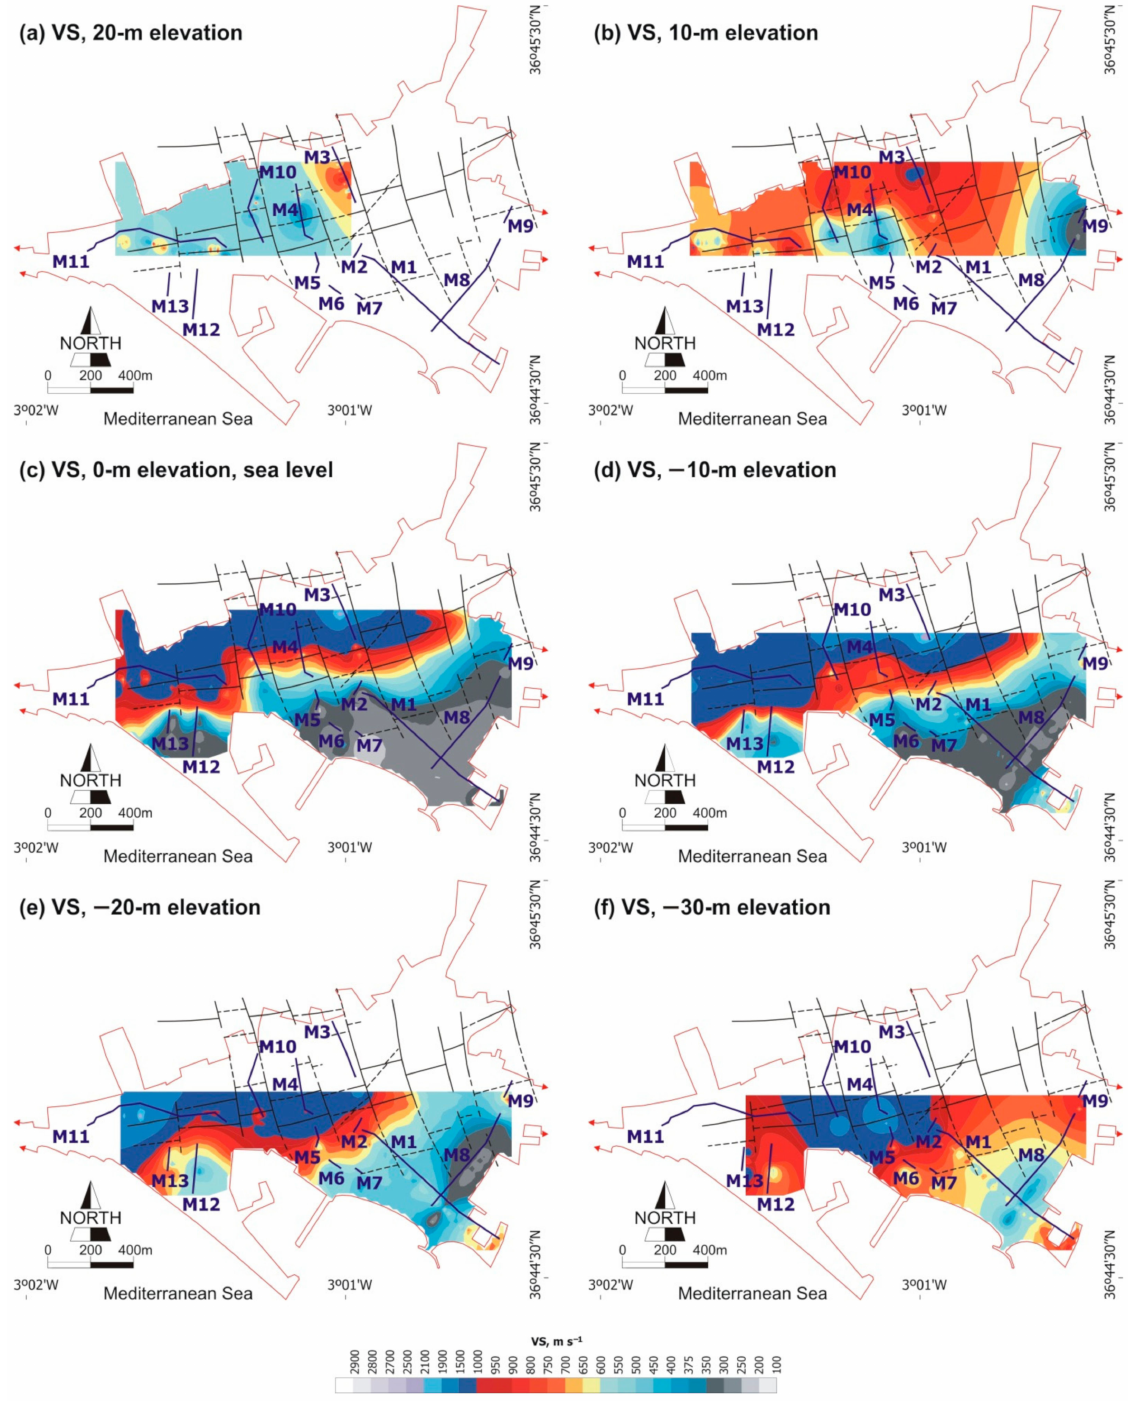
Figure 4. Some MASW maps at different elevation regarding the sea level in Adra town, showing observed and inferred normal and strike-slip fault systems, and location of MASW sections M1 to